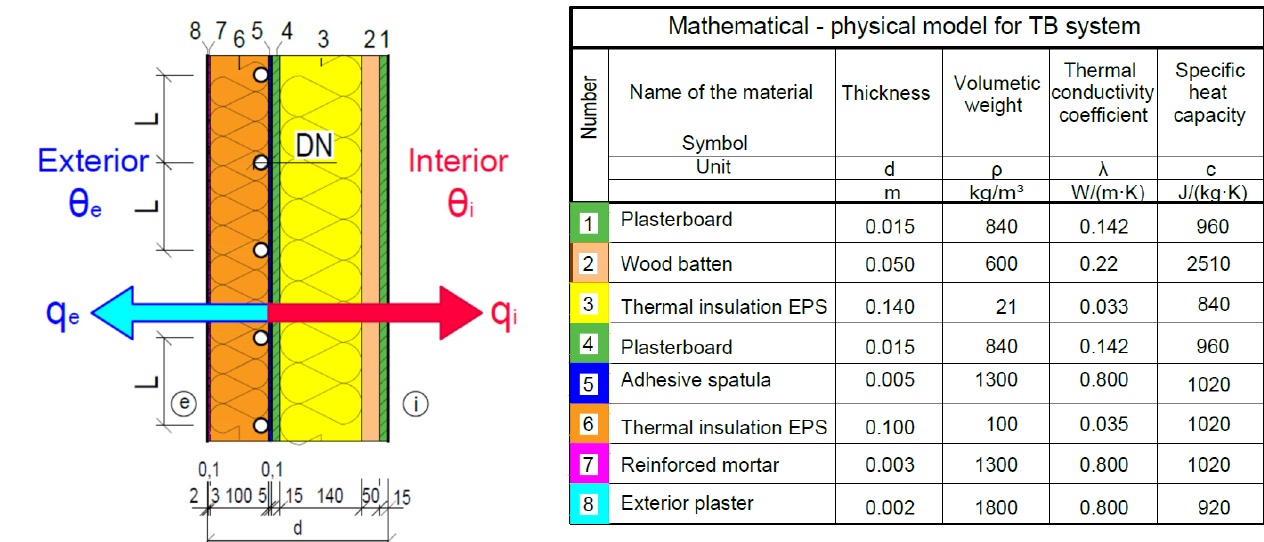
Figure 7. The procedure for solving a computer simulation in ANSYS.